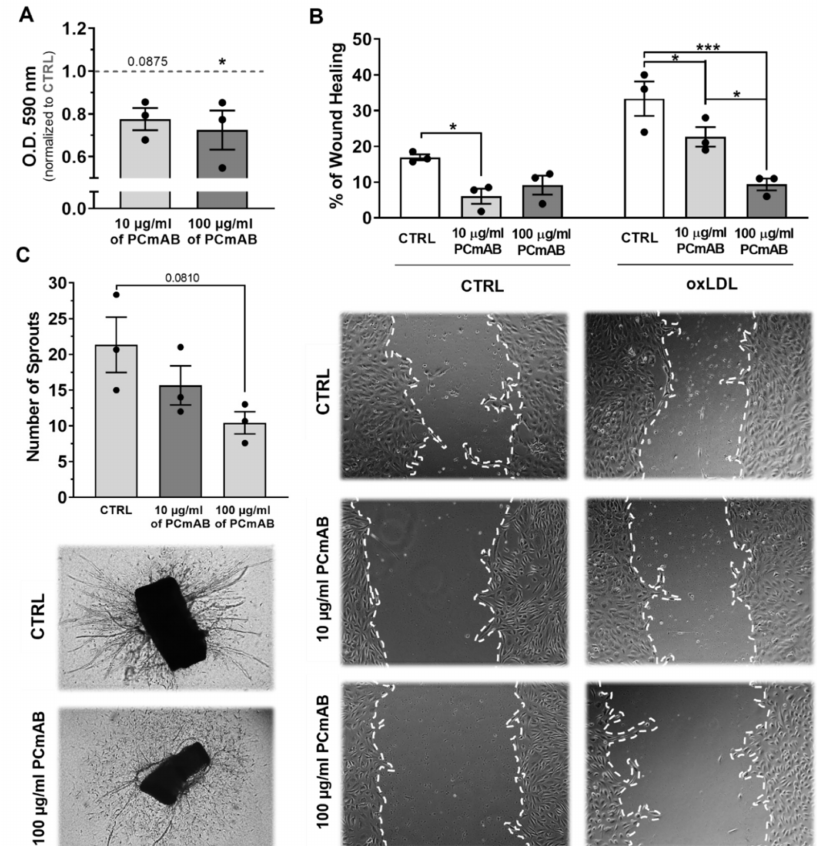
Figure 5. PC-mAb reduces HUVEC metabolic activity and HUVEC migration in vitro and neovessel sprouting ex vivo. Quantification of PC-mAb effects on the MMT assay ( A ), on the migration assay ( B ), and on the aortic ring assay ( C ). Representative images of the scratches on HUVEC mono-layers ( B ) treated with increasing doses of PC-mAb and with and without 5 µ g/mL oxLDL, 16 h after scratching. Representative images of the aortic rings ( C ) treated with VEGF and PC-mAb. ( A ) Data normalized to CTRL group (indicated as 1 by a dashed line in the graph) and presented as mean ± SEM (n = 3). * p < 0.05, by 1-way ANOVA (*are significances versus control). ( B ) Data presented as mean ± SEM (n = 3). * p < 0.05, *** p < 0.001; by 2-way ANOVA. ( C ) Data presented as mean ± SEM (n = 3) by 1-way